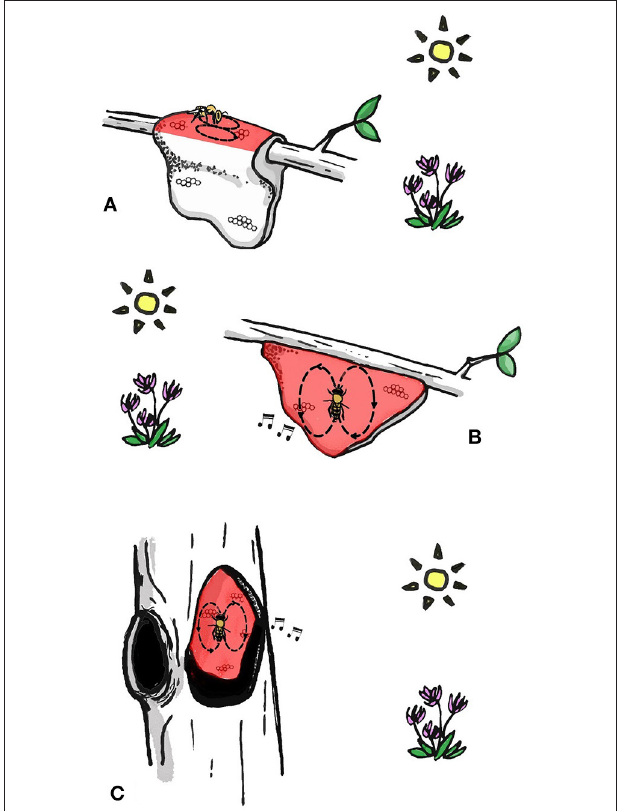
FIGURE 1 | The increasing sophistication of the dance language with phylogenetic development of the dance. (A) Dwarf honey bees perform dances on horizontal surface in the direction of the food source. (B) Giant honey bees perform dances on vertical surface and orient dances with gravity and celestial cues. Apis dorsata also has auditory cues when dancing. (C) Cavity-nesting honey bees perform dances in darkness on a vertical surface. Dances are oriented with gravity and celestial cues. All species produce auditory cue when dancing. Bees in (B,C) are both dancing directly upwards, indicating that the food source is in the direction of the sun. Areas of the comb on which bees dance are colored